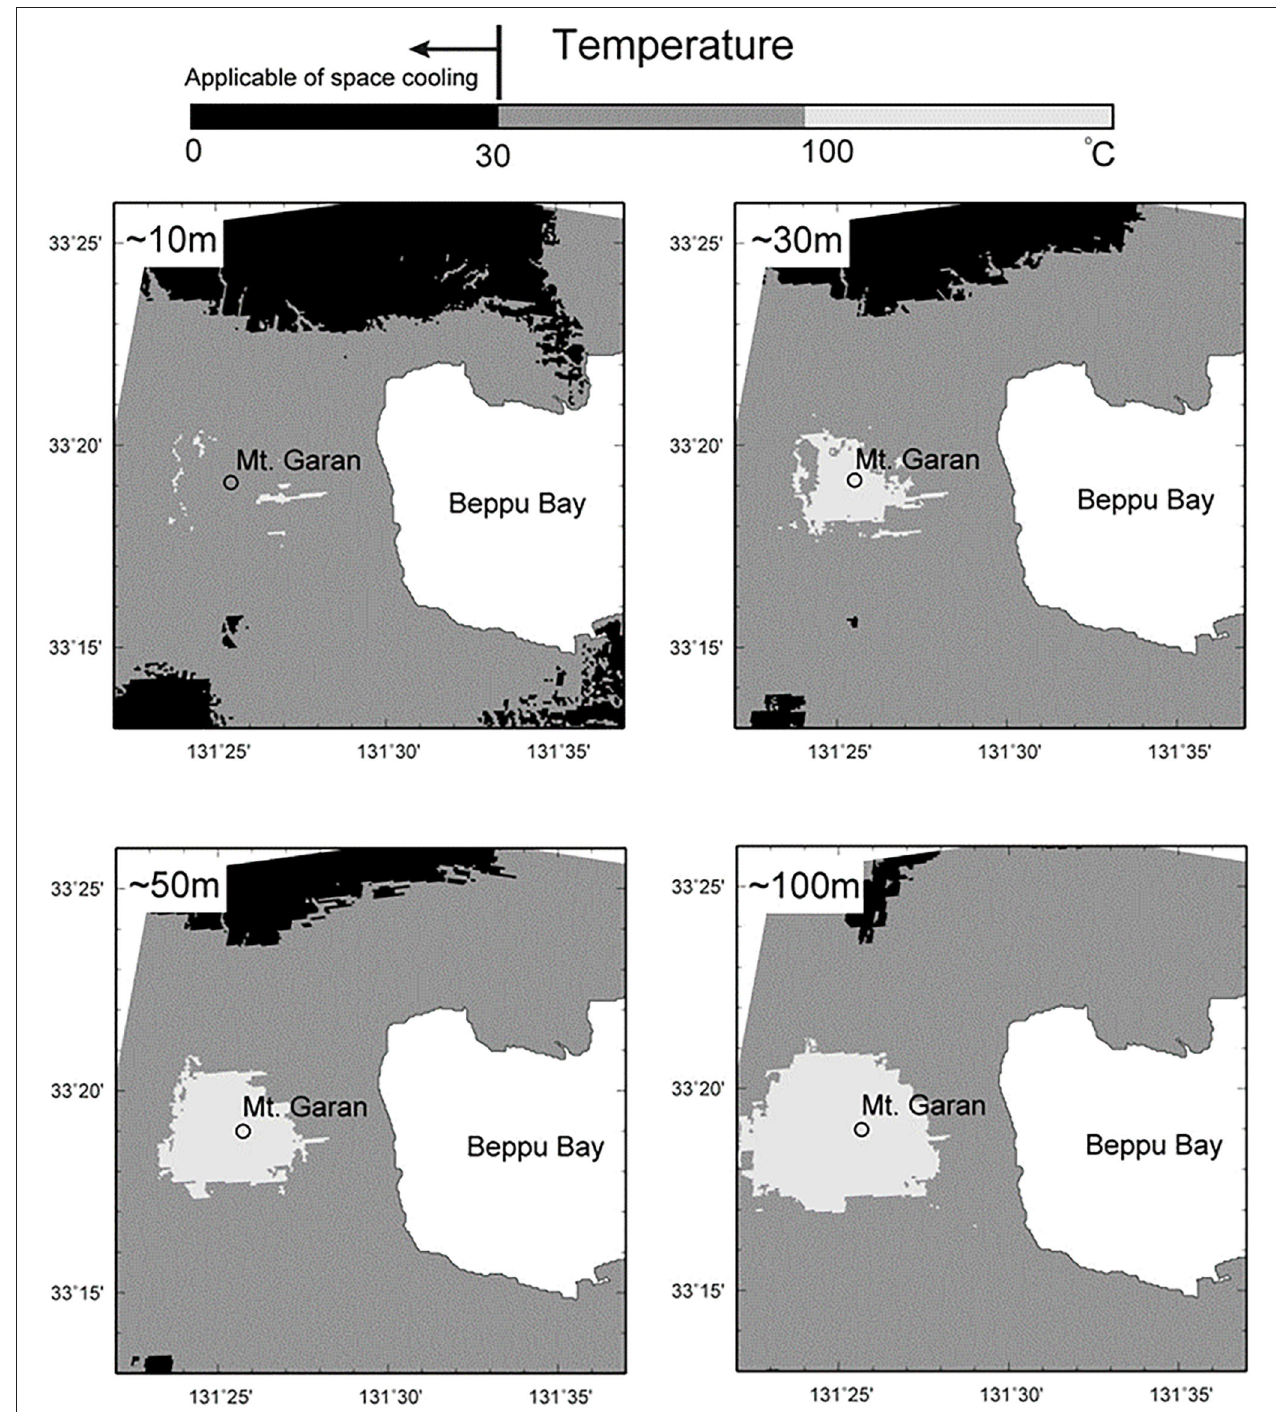
FIGURE 5 | Evaluation of the applicable area for GHE systems. GHE, geothermal heat exchanger.